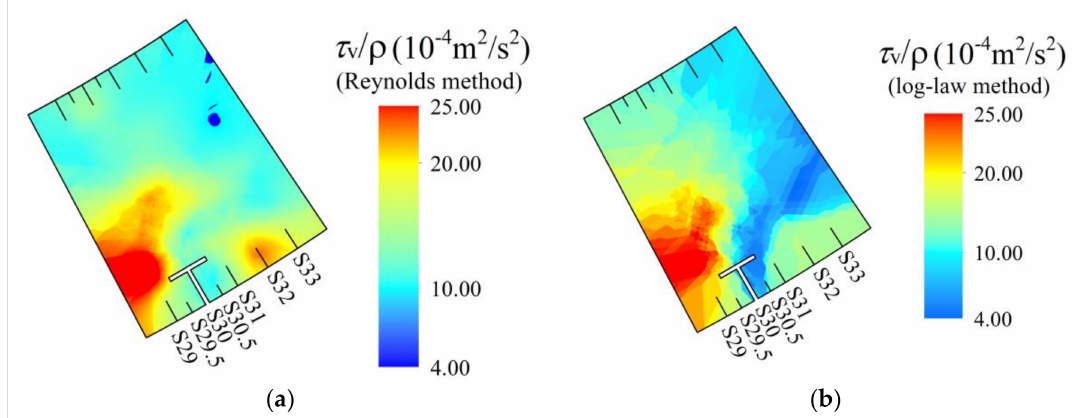
Figure 8. Transverse bed shear stress estimates: ( a ) Reynolds method; ( b ) log-law